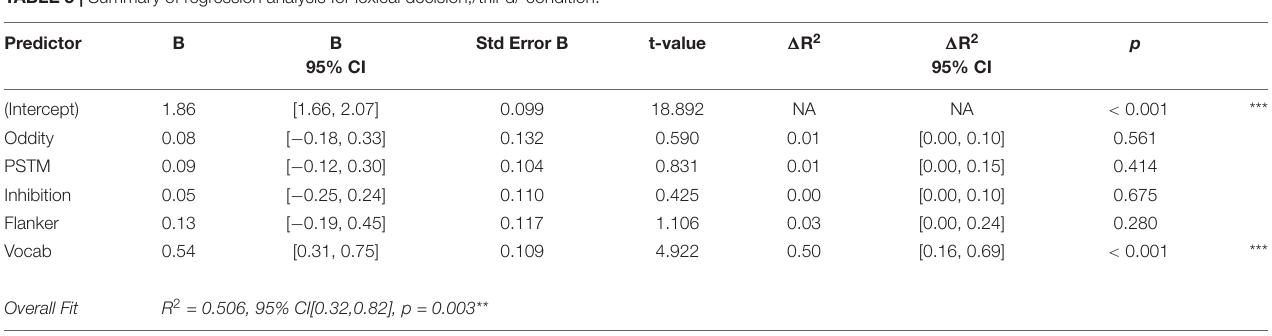
TABLE 5 | Summary of regression analysis for lexical decision,/trill-d/ condition.